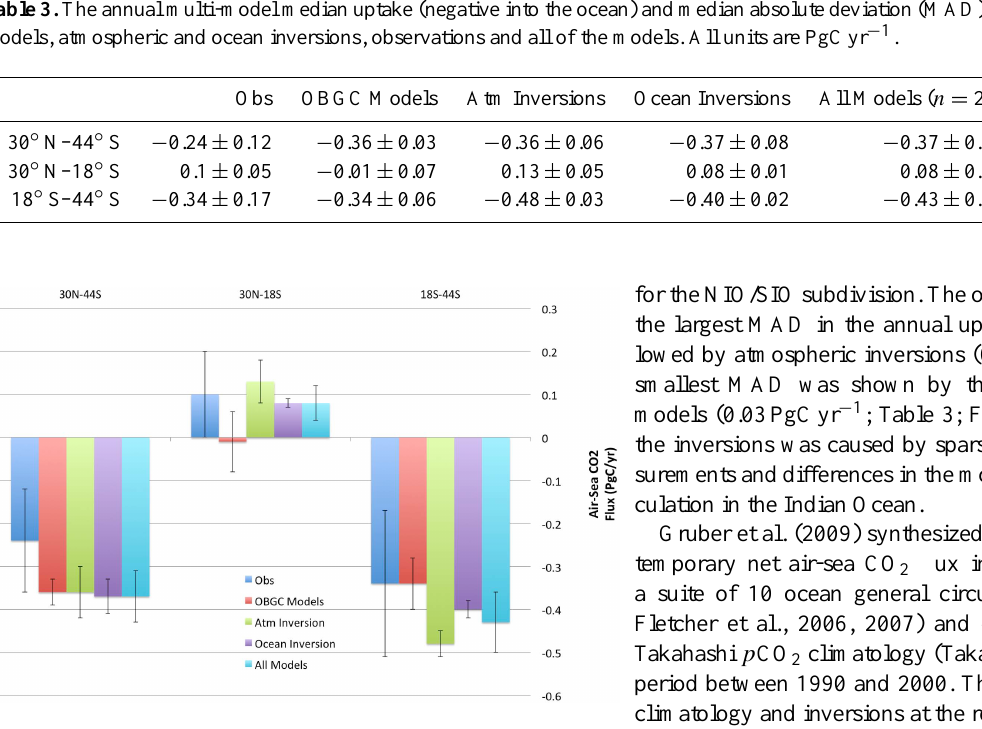
Fig. 3. Annual median uptake from observations, ocean biogeo- chemical models, atmospheric inversions and ocean inversions (PgCyr − 1 ) . The error bars represent the median absolute deviation (MAD). Negative values represent fluxes into the